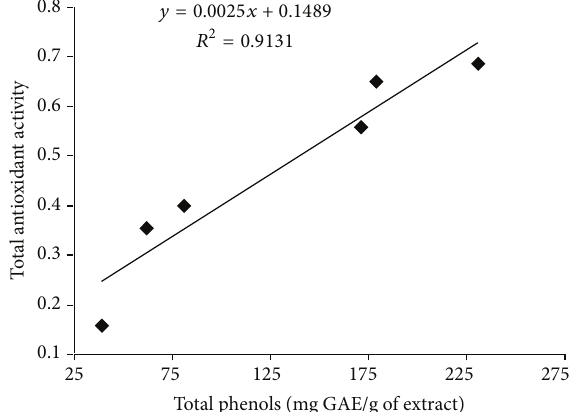
Figure 8: Correlation between total phenols and total antioxidant activity of leave extracts of Loranthus pulverulentus .